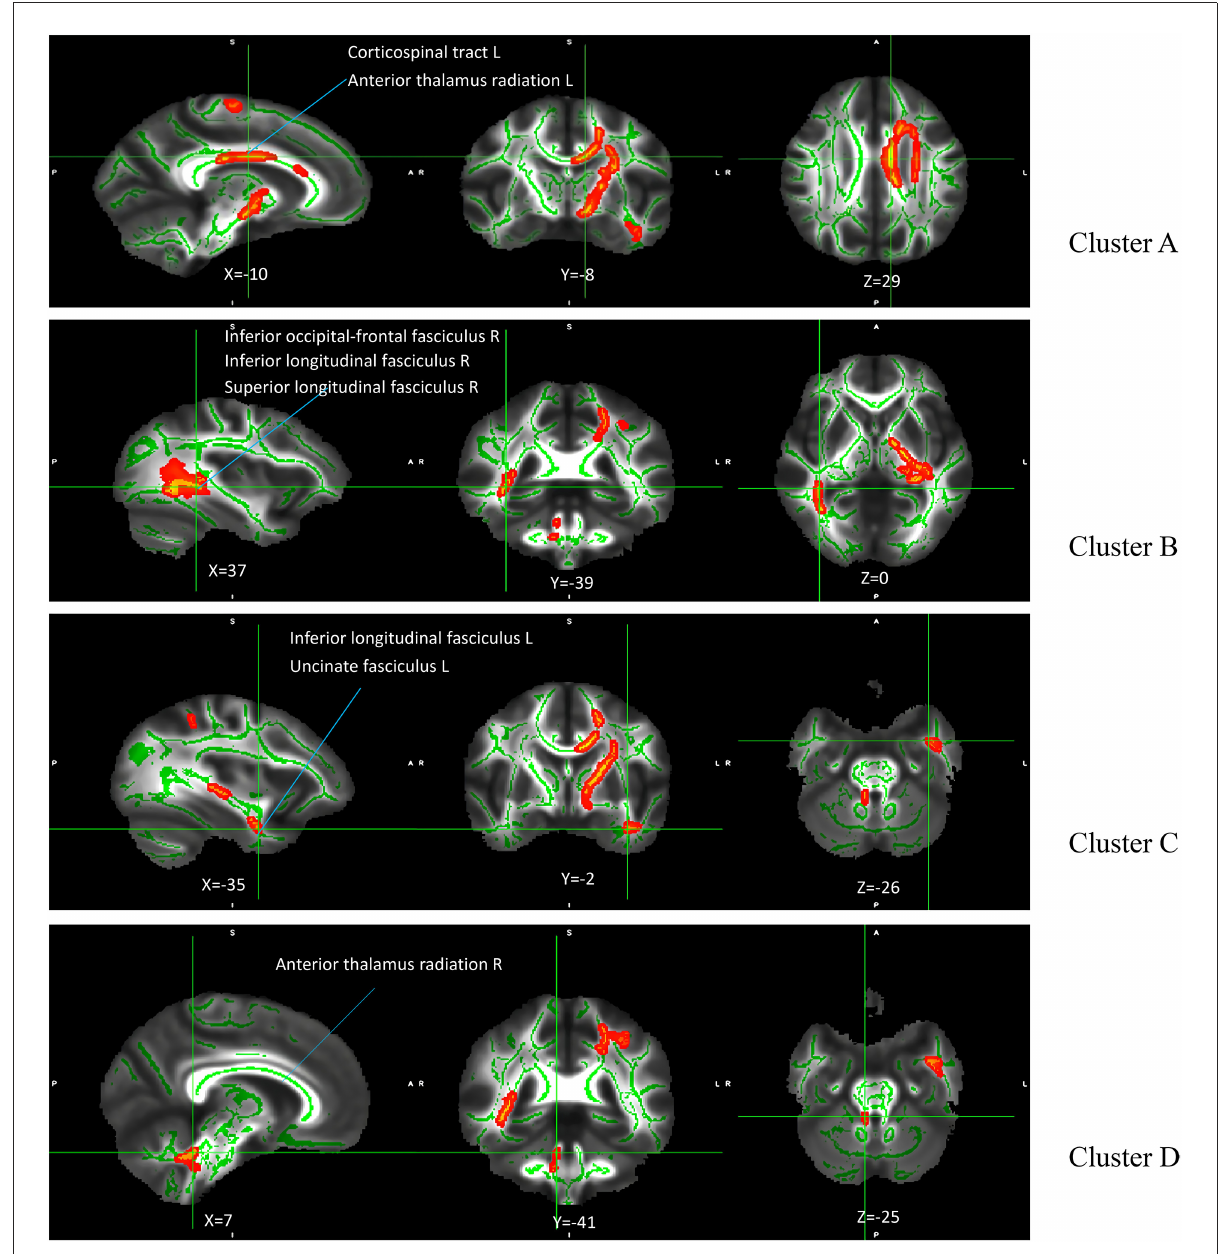
FIGURE5 Main effect of diagnosis on FA among the four groups. The green regions indicate FA white matter skeletons. Red-yellow regions indicate significantly different FA between the four groups. All statistical maps are thresholded at P < 0.05 (after TFCE correction for multiple